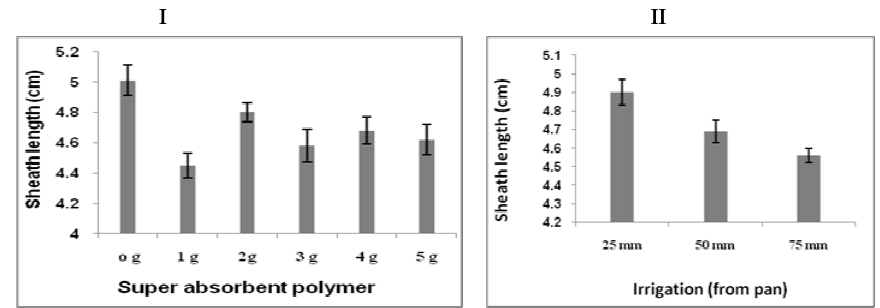
Fig. 1. Means comparison of sheath length of Brassica napus L. treated with varying amounts of super absorbent (I) under different Irrigation regimes (II). The same letters show non-significant differences